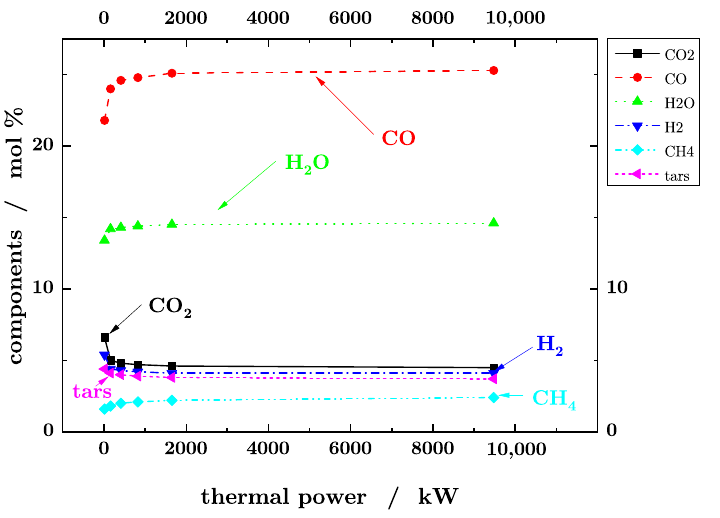
Figure 10. The influence of the gasifier size (thermal input) on the gas composition for constant residence time scaling